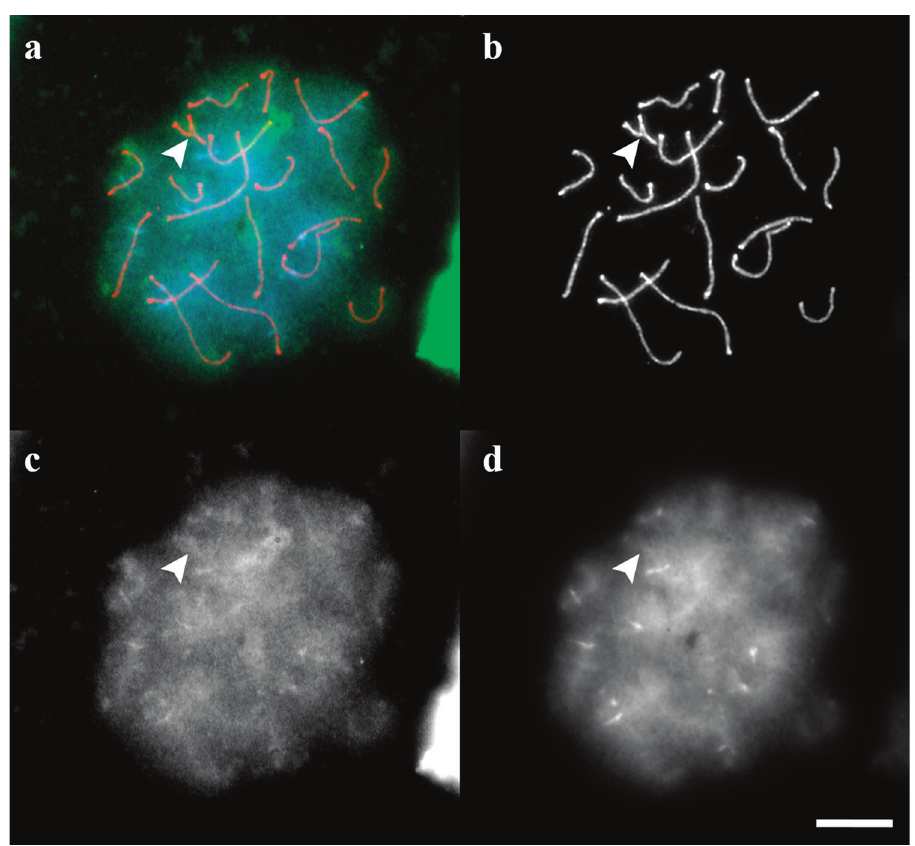
b SYCP3 c CMA3 d DAPI. Arrowhead shows SC 19. Scale bar: 10